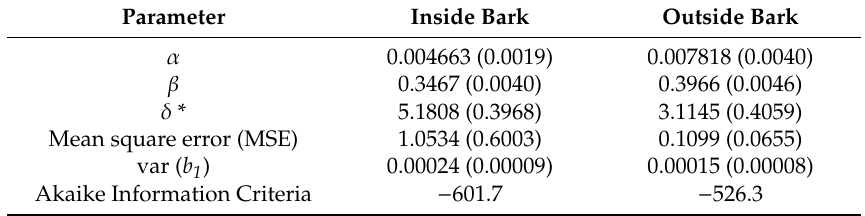
Table 3. Parameter estimates (standard error) and fit statistics of Equation (5) fitted to inside and outside bark volume data using a nonlinear mixed-e ff ects method for red pine plantations in